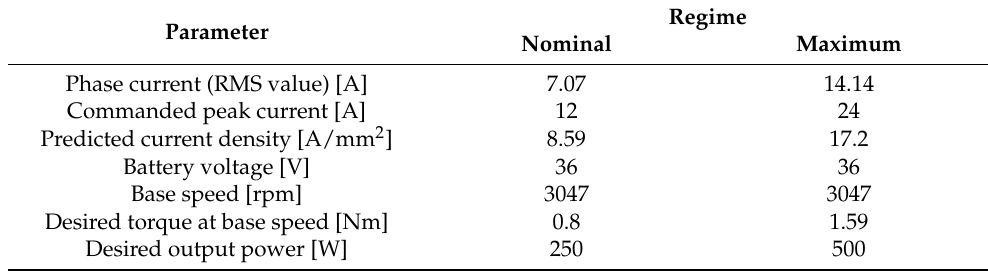
Table 5. Main electrical constraints.